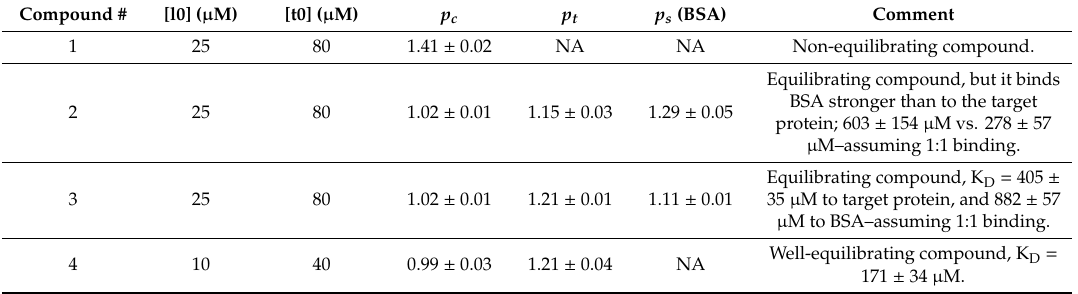
Table 2. Summary of results obtained with the q µ D protocol on compounds, which showed low dialisability (1), nonspecific binding (2), strong specific and weak nonspecific binding (3) and a specific binder, which a ffi nity to the target was compared to the a ffi nity determined by NMR. Compound # [l0] ( µ M) [t0] ( µ M) p